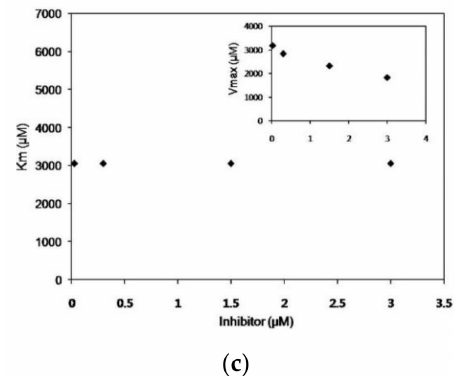
Figure 1. Dixon and Lineweaver–Burk plots for the inhibitory activity of sulforaphane against BACE1. Dixon plots show the e ff ects of the presence of di ff erent substrate concentrations: – 250 µ M; - - (cid:72) - 750 µ M for sulforaphane ( a ). Lineweaver–Burk plot was analyzed in the presence of di ff erent